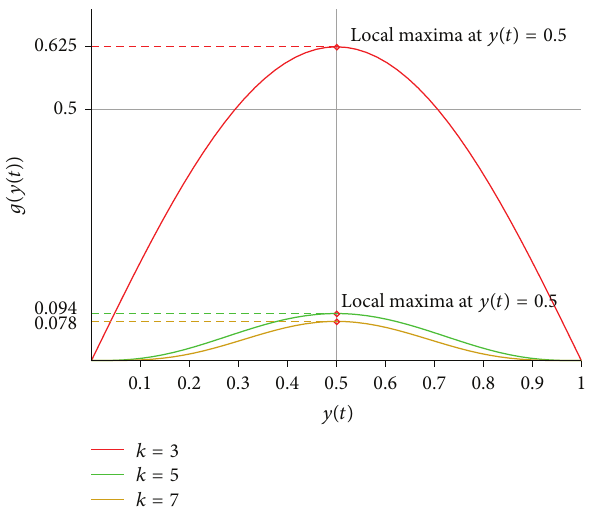
Figure 1: A plot of 𝑔(𝑦(𝑡)) as a function of 𝑦(𝑡) for odd values of 𝑘 .